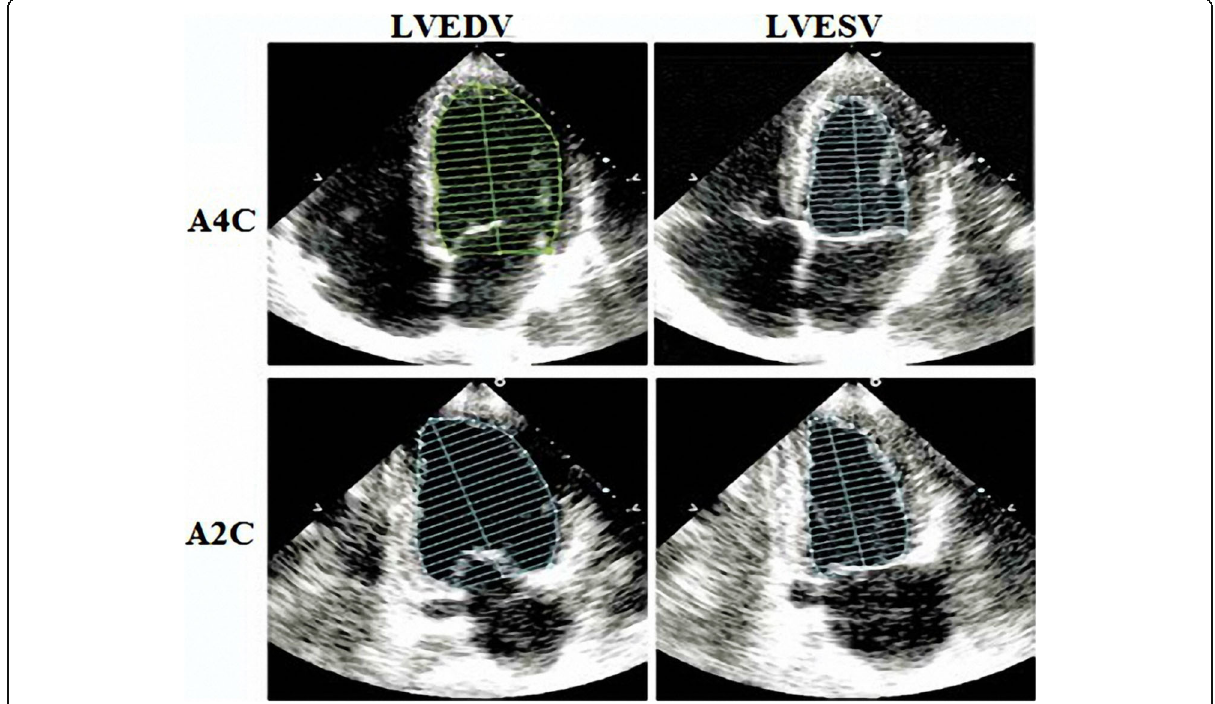
Fig. 1 Method of calculation of biplane Simpson method. LVEDV: Left ventricular end-diastolic volume, LVESV: Left ventricular end-systolic volume, A4C: Apical 4-chamber view, A2C: Apical 2-chamber